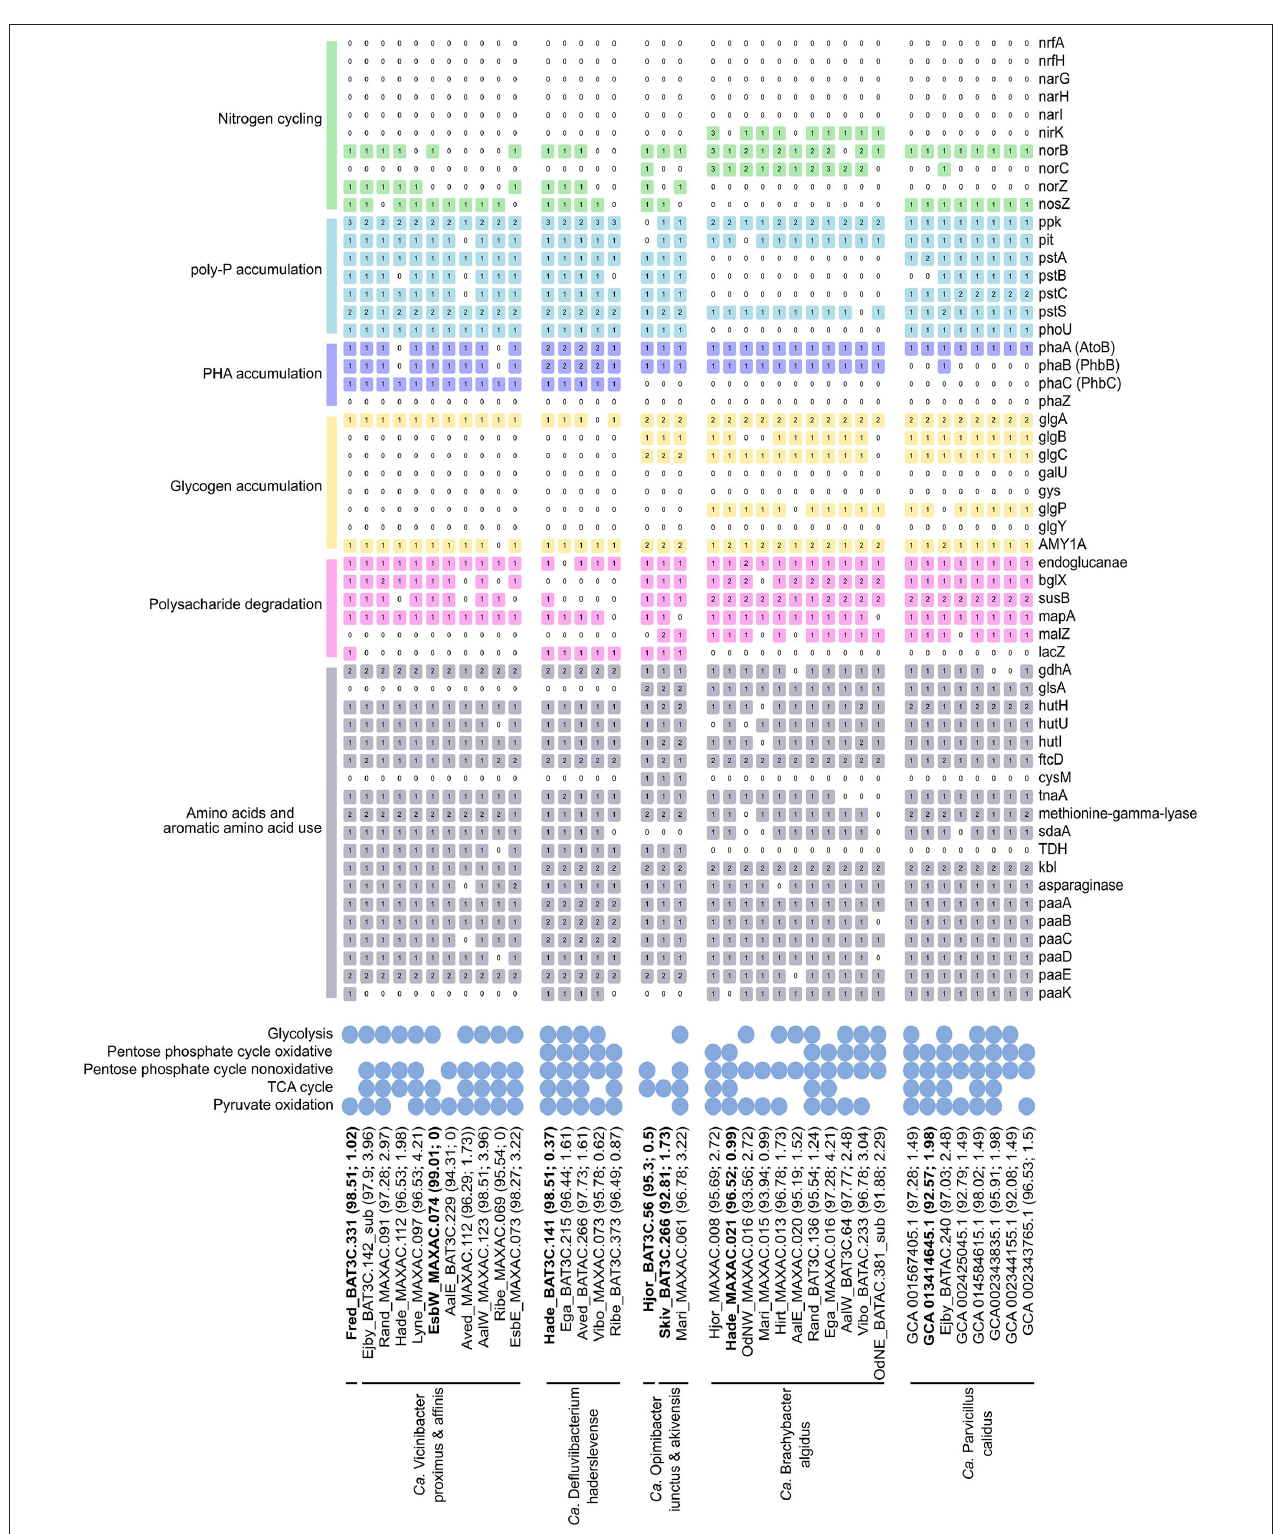
FIGURE 5 | Basic functional potential of the Ca. Vicinibacter, Ca. Defluviibacterium haderslevense, Ca. Opimibacter, Ca. Brachybacter algidus, and Ca. Parvibacillus calidus. The number in colored boxes represents gene copy number. The gene list follows the progression in the text. For the full list of gene names and associated KO numbers, see Supplementary data 3 . The genomes are ordered as in the genome tree in Figure 4 , with their genome completeness and contamination indicated within the parentheses. Species representatives are in bold.